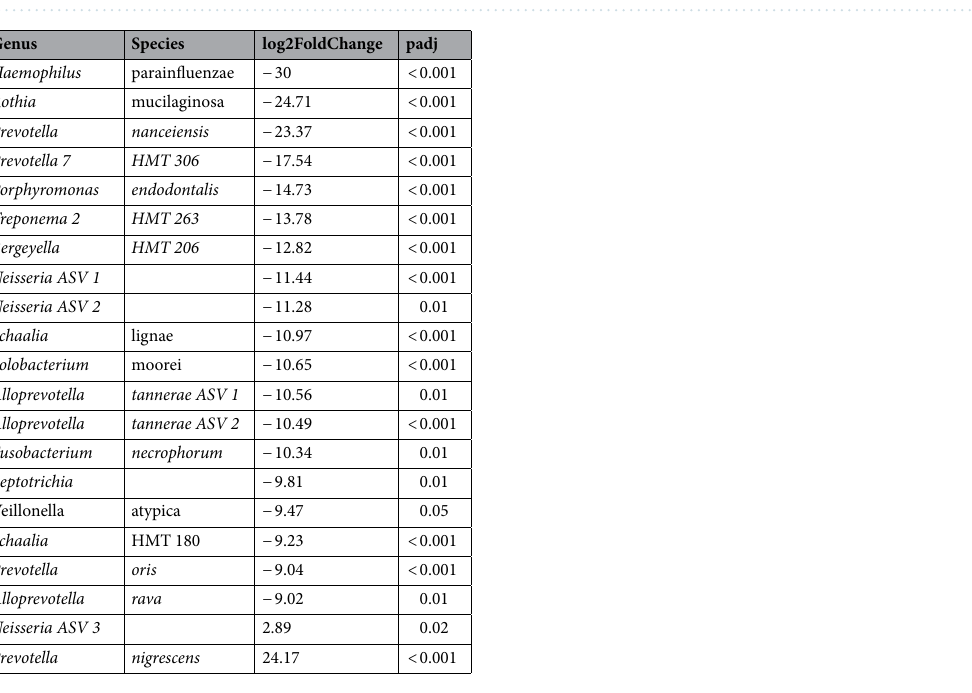
Table 2. Statistically significant log2-fold change differences in the abundance of salivary bacterial taxa between depressed and healthy subjects.